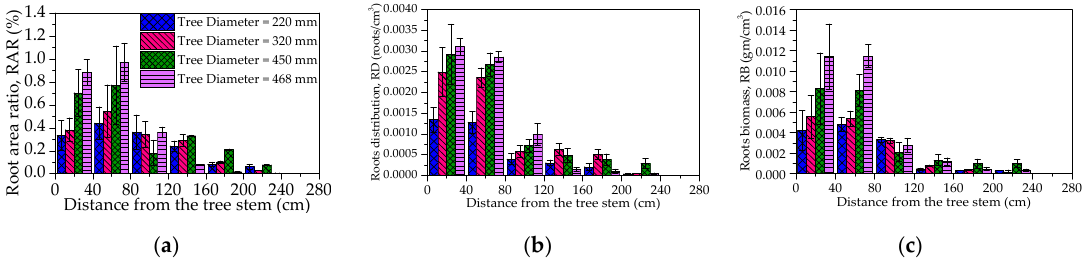
Figure 8. Variation of roots indices with lateral distance from the tree stem ( a ) RAR ( b ) RD, and ( c ) RB.